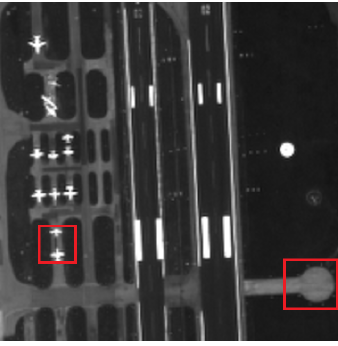
Figure 10. Four regions cropped from the SR result shown in Figure